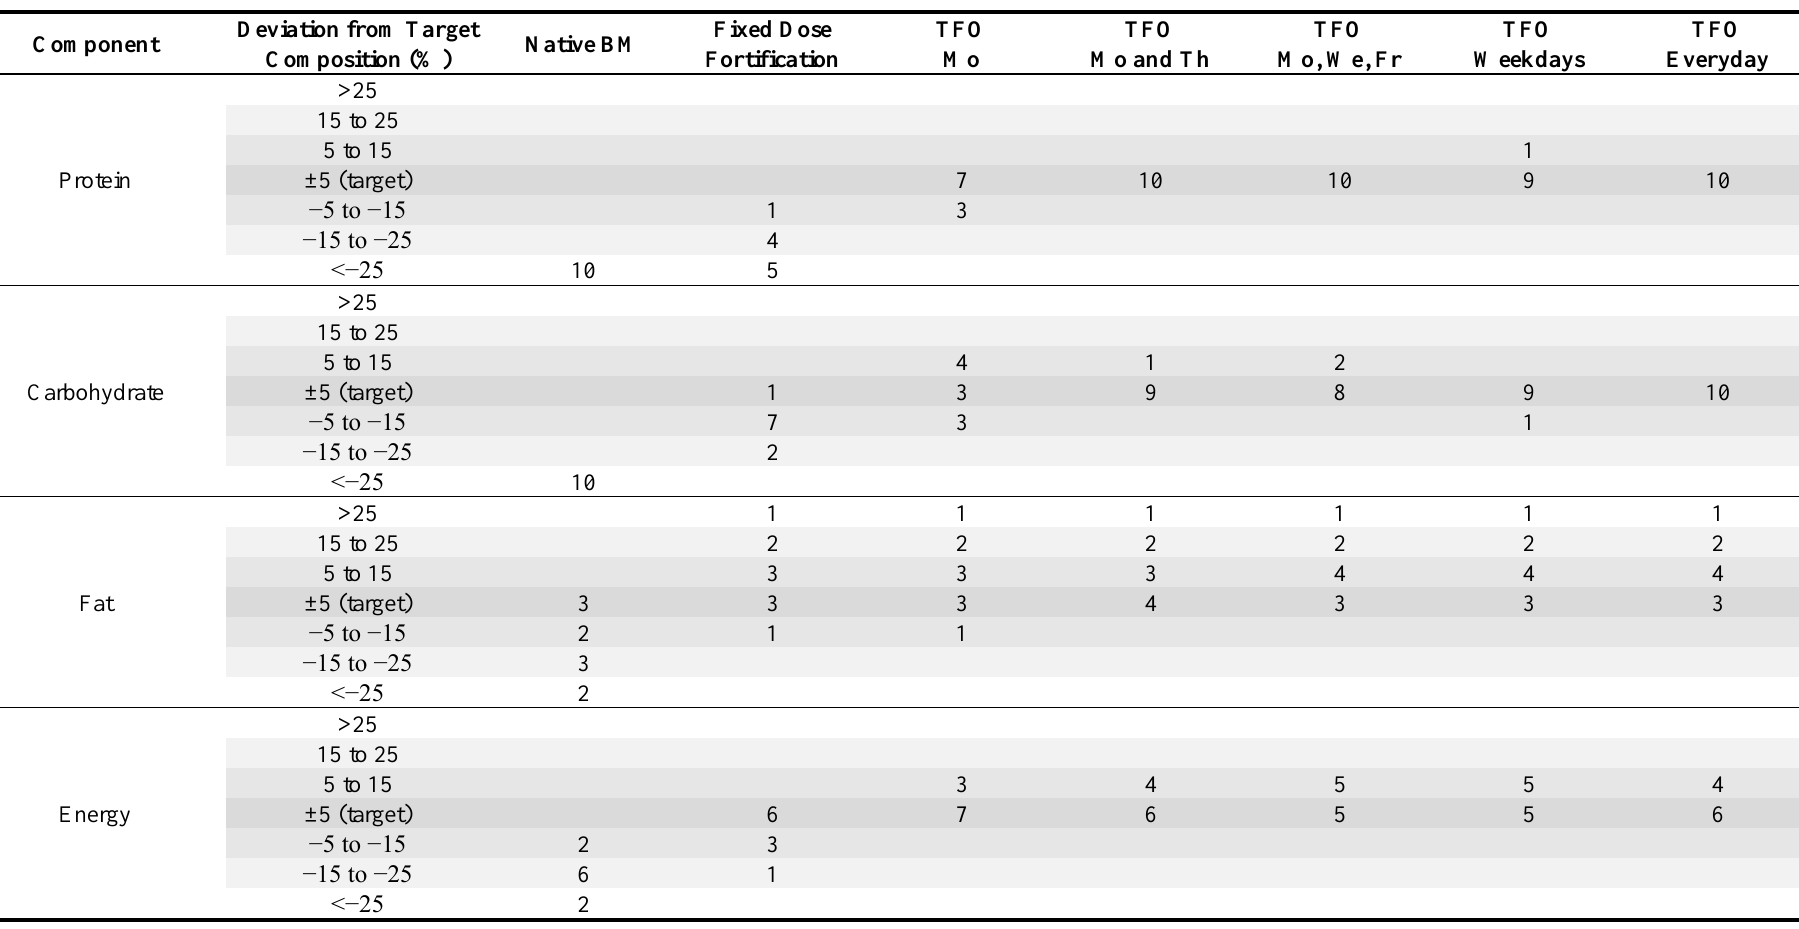
Table 2. Number of subjects affected by the deviation of mean macronutrients and energy intake from ESPHGAN recommendations. Data ( n = 210 measurements of n = 10 subjects) presented for native breast milk (BM), fixed dose fortified BM and of target fortified (TFO) BM for measurements done on different schedules for BM